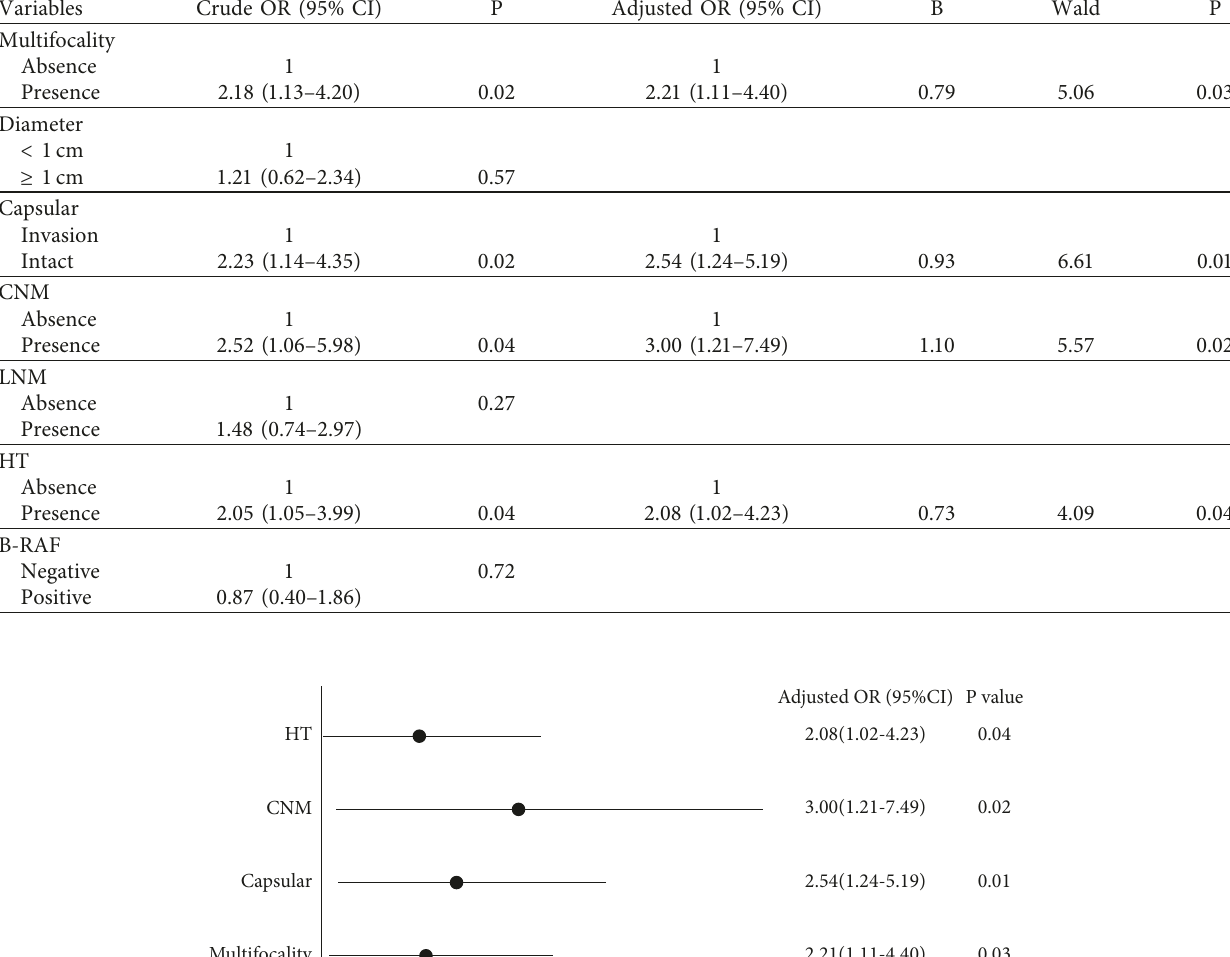
Table 2: Univariate and multivariate analyses of predicting factors of COPTC.